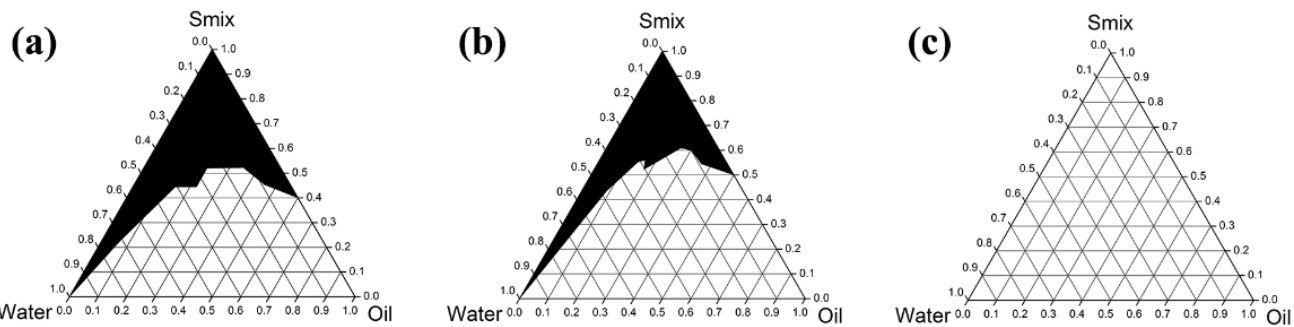
Figure 6. Pseudoternary phase diagrams of AGO/Tween ® 20/PG/water when the Tween ® 20/PG ratios were 4:1 ( a ), 1:1 ( b ), and 1:4 ( c ). Table 3. Internal droplet size and PDI of AGO microemulsion before and after the stability test.